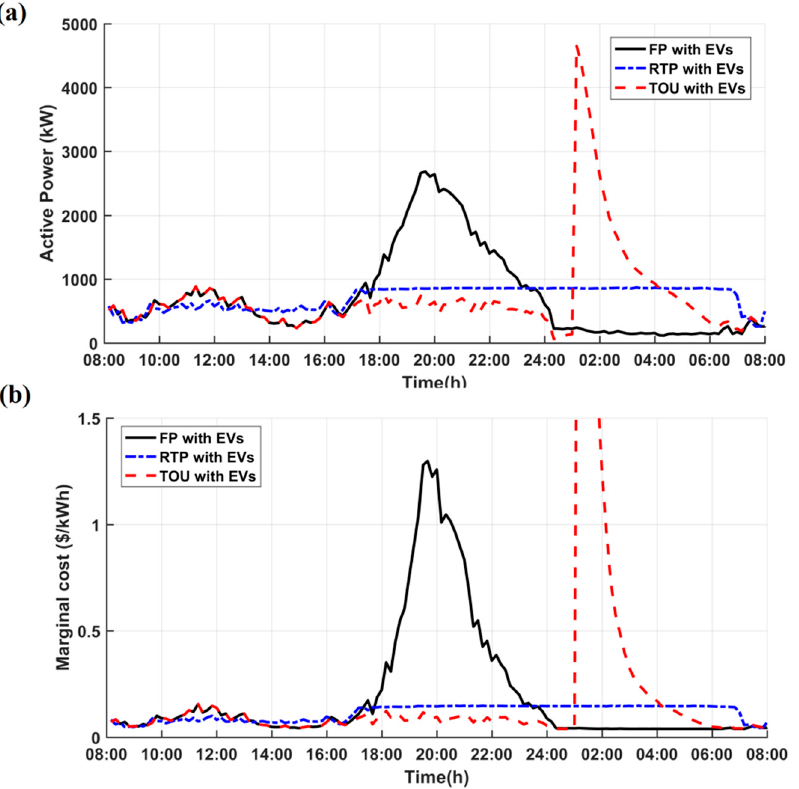
Figure 6. ( a ) Total active power and ( b ) Marginal cost of the proposed transactive method, FR, and TOU, in a grid with high penetration of EVS.